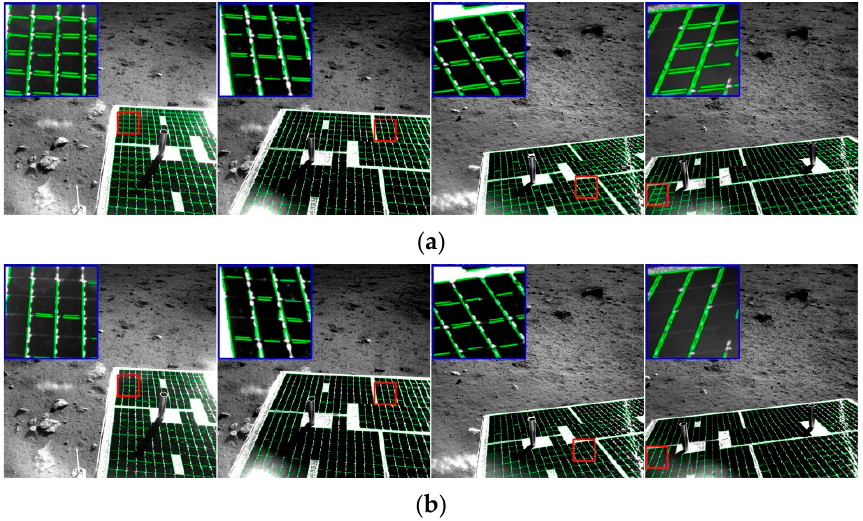
Figure 19. Line extraction results of solar panels by different methods. ( a ) Is the line detection result of the proposed method. ( b ) Is the Line extraction result of the LSD method.the subgraph is a detailed display of the red square box area. The green lines are the lines detected by the corresponding method.